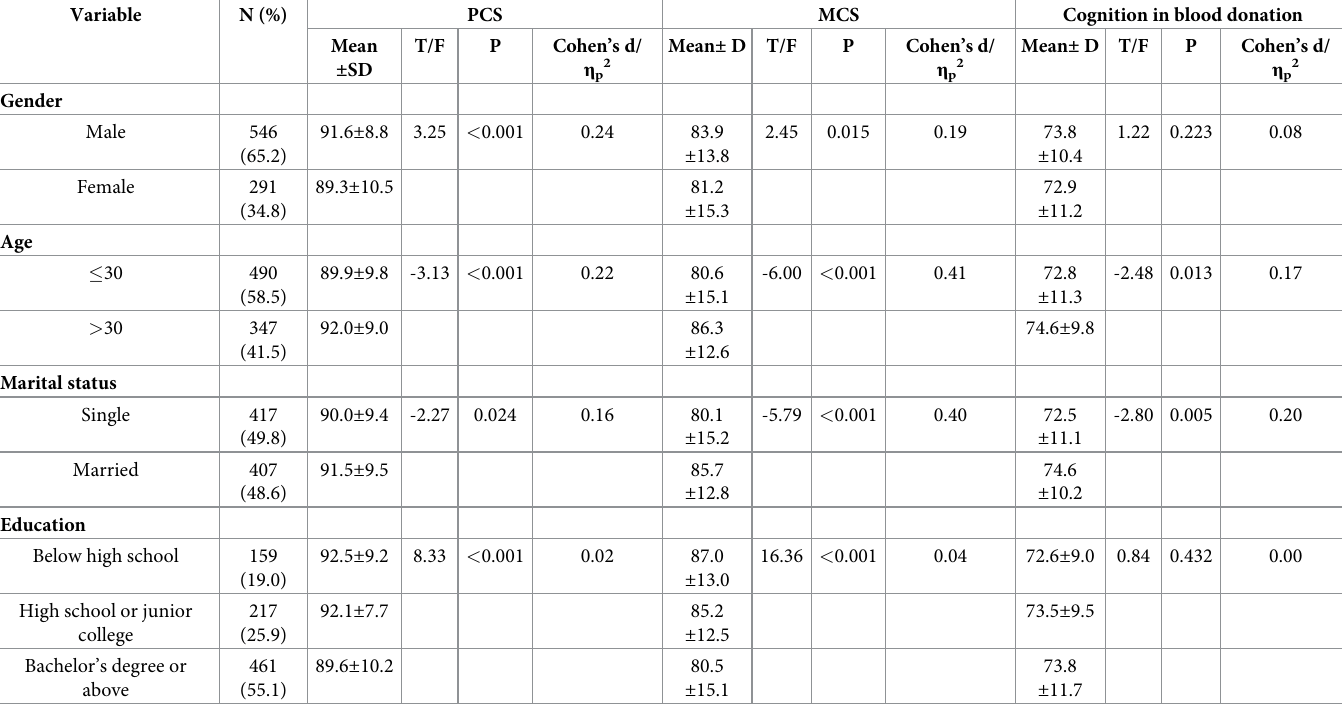
PCS: physical component summary; MCS: mental component summary; SD: standard deviation. Nonparametric Test and Cohen’s d were used to analyze